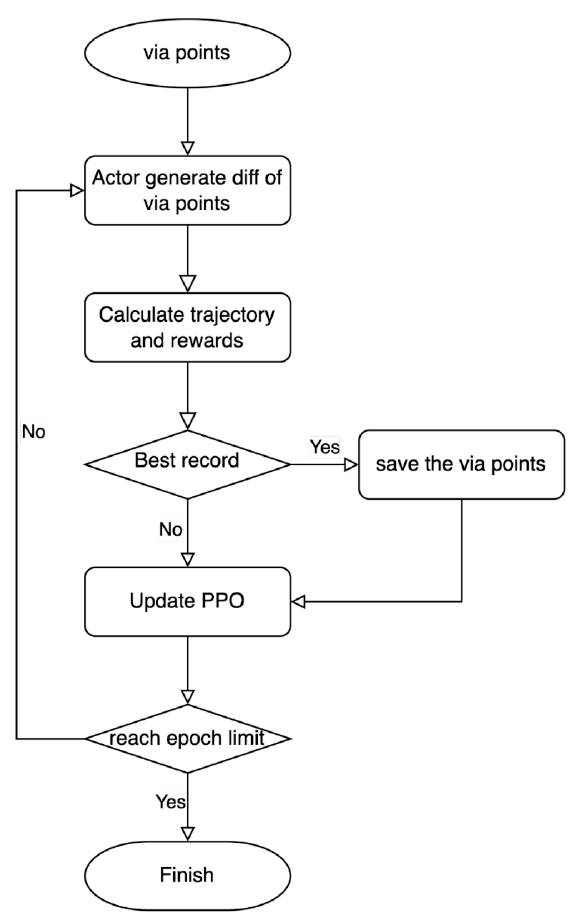
Figure 6. The optimization algorithm for via points.